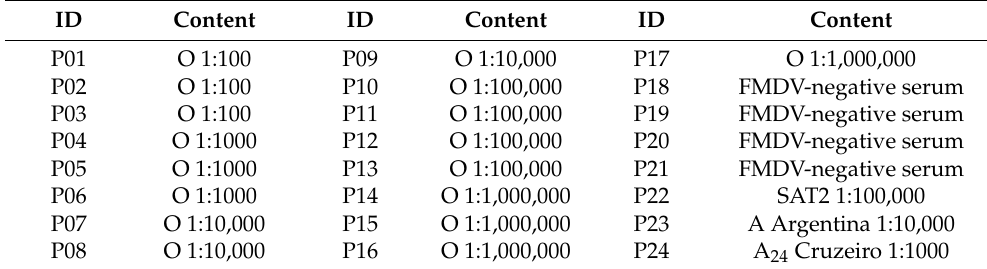
Table 1. Sample panel for virological testing.